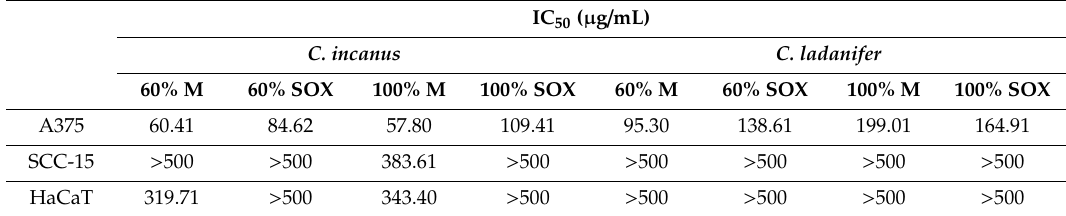
Table 5. In vitro cytotoxicity of C. incanus and C. ladanifer extracts against human malignant melanoma (A375), human scquamous cell carcinoma (SCC-15), and non-cancerous human keratinocyte (HaCaT) cell lines; each value represents mean IC 50 ( µ g / mL) from three